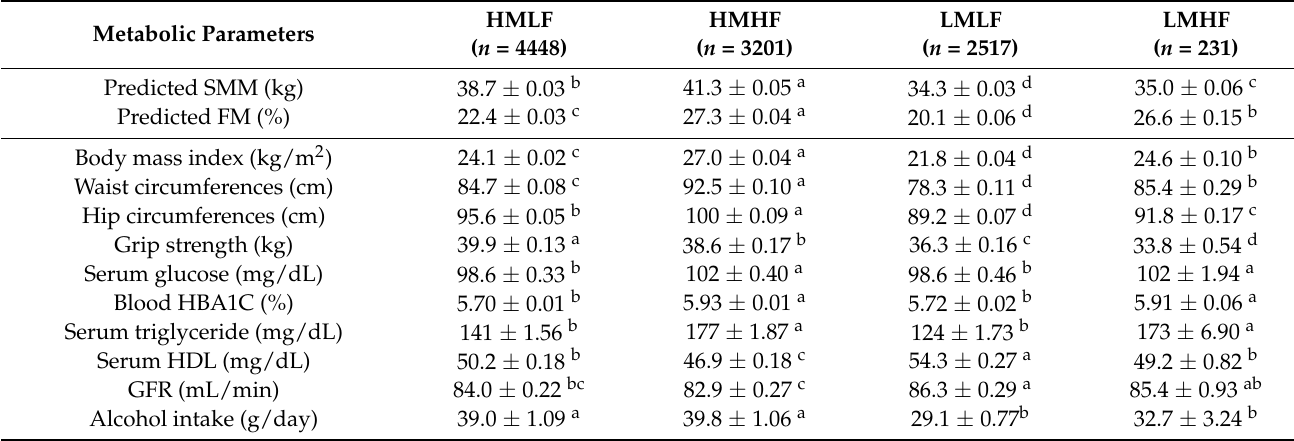
Table 3. Adjusted means 1 and standard errors in anthropometric and biochemical parameters according to skeletal muscle mass (SMM) and fat mass (FM) in men at the urban hospital-based cohort.